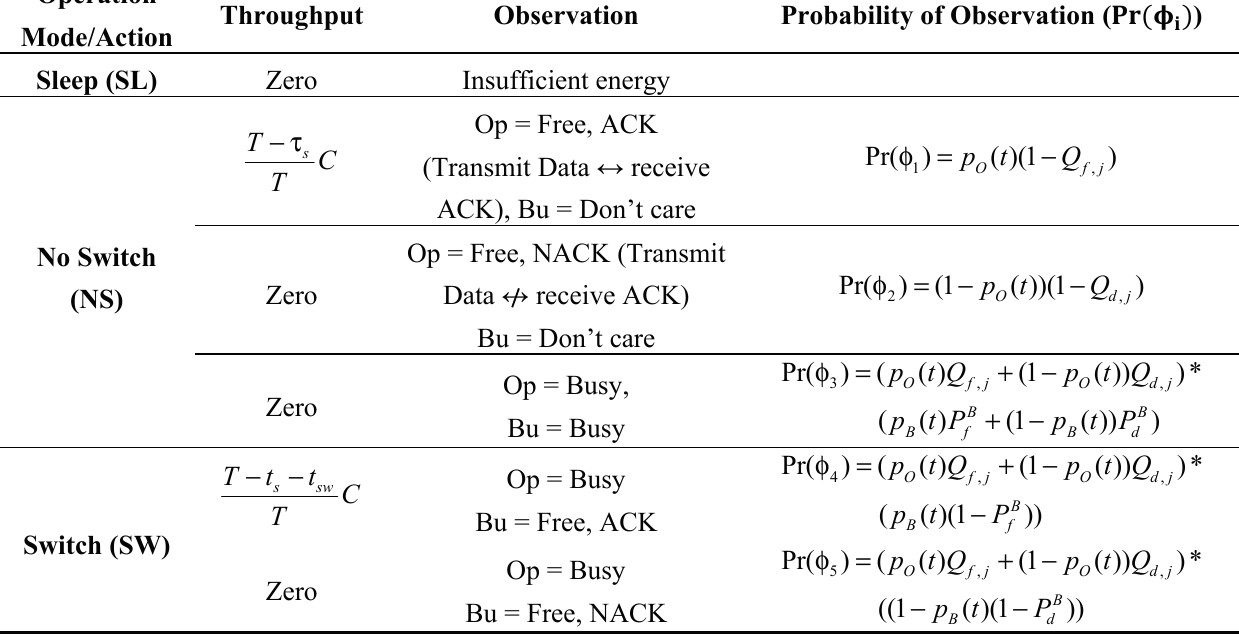
Table 1. Summary of the throughput, observations, and observation probabilities.